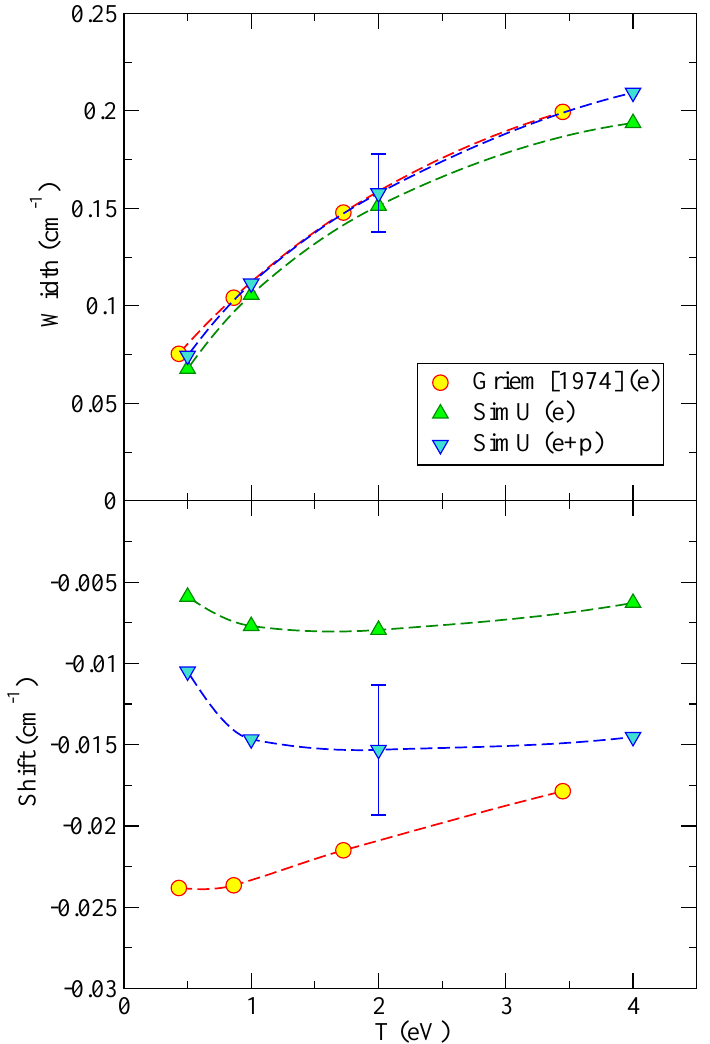
Figure 1. The Stark width (FWHM) and shift of the OI 777-nm line assuming a plasma with n e = 10 16 cm − 3 . Shown are results for a one-component electron plasma (“e”) and those for a proton-electron one (“e+p”). “Griem [1974]” stands for [3], “SimU” labels our results. The error bars indicate estimated uncertainties of our